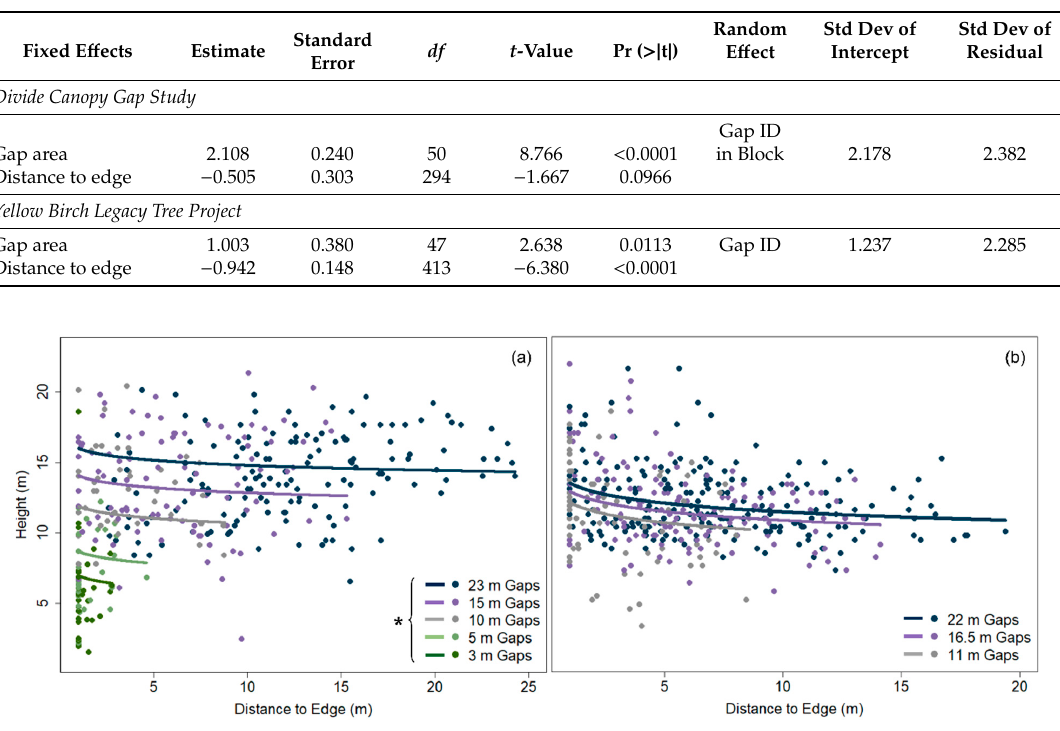
Figure 2. Relationships between gap-capturing sapling height (m), distance from gap edge (m), and gap area (m 2 ) for two group-selection study sites in northern hardwood forests of the upper Great Lakes, USA: ( a ) Divide Canopy Gap Study (DCGS); ( b ) Yellow Birch Legacy Project (YBLP). Dots represent individual gap-capturing saplings color-coded by opening-size class. Lines represent linear, mixed-effects model fits of sapling height predicted by gap area and distance from gap edge (Table 3). Average areas from each opening-size class were used as constant values to calculate fit lines of height versus distance from gap edge. *Distance from gap edge was not a significant predictor of sapling height in the DCGS model.